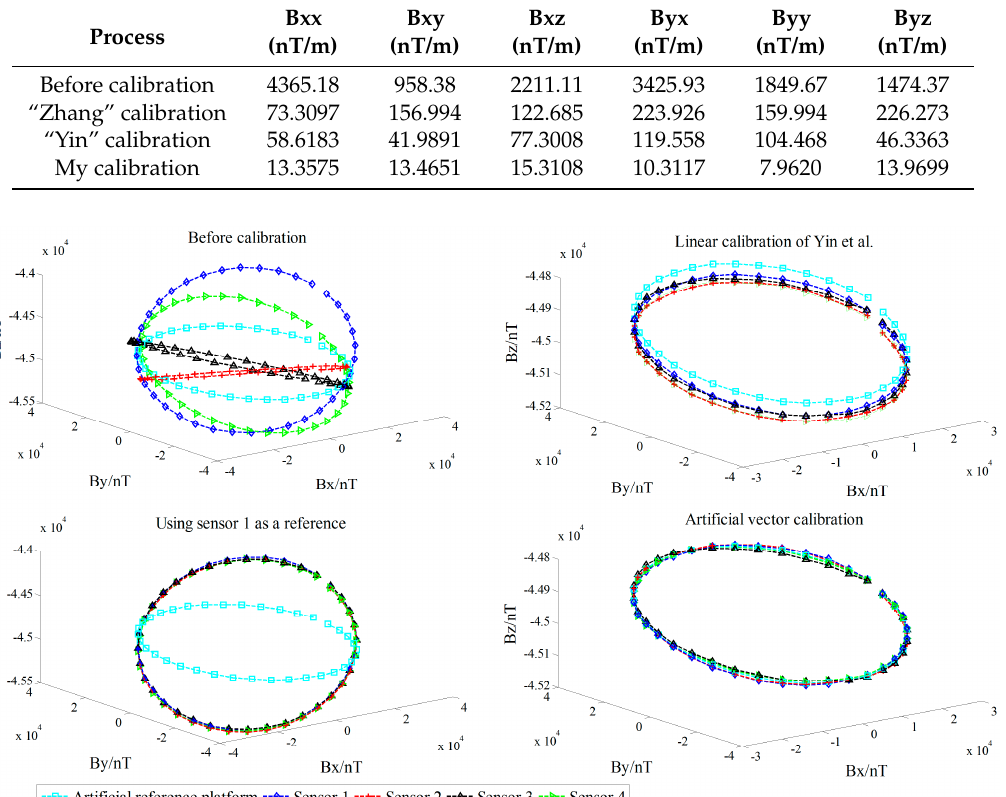
Table 5. RMSE of tensor components before and after calibration in the experiment.